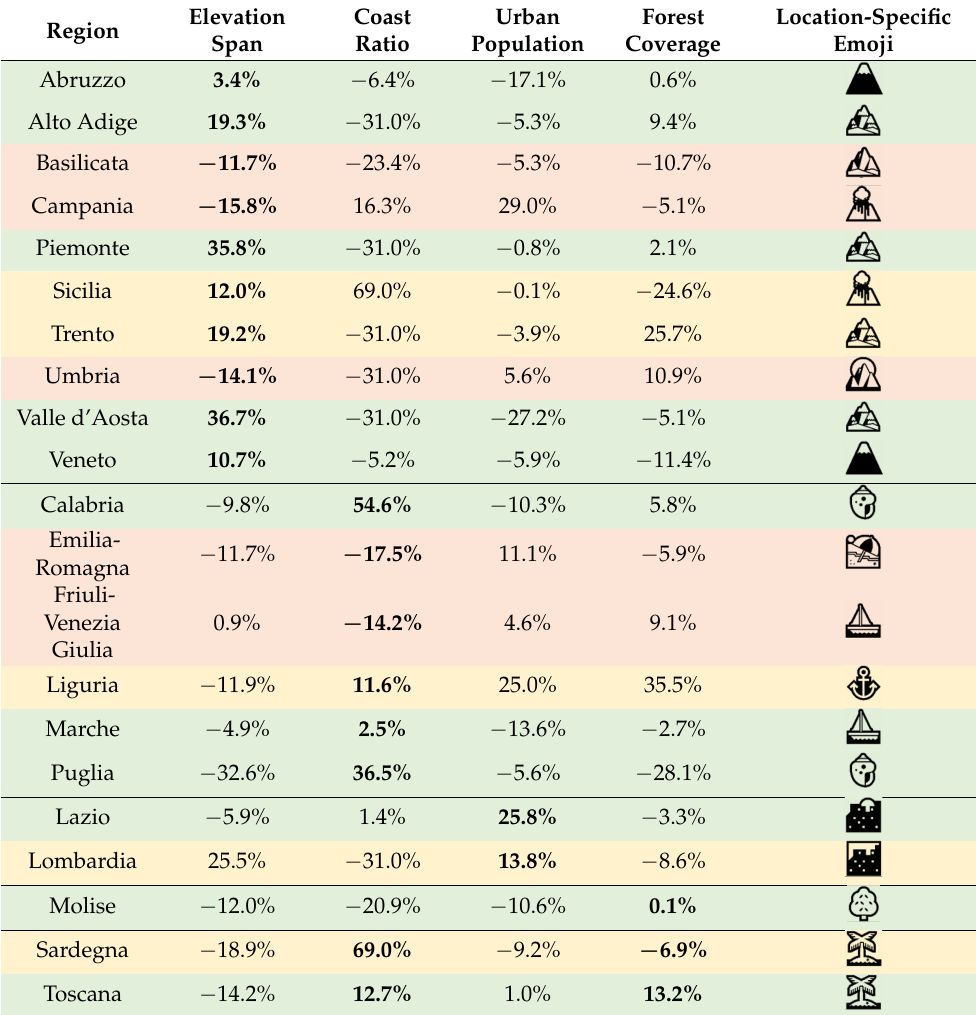
Table 4. Typical location-specific emojis and the percentage deviation of the four geographical attributes from the overall Italian average per administrative region (bold: respective representative geographical attribute; green: deviation of representative geographical attribute is above overall Italy average and the maximum; yellow: deviation of representative geographical attribute is above overall Italy average, but is not the maximum; red: deviation of representative geographical attribute is below overall Italy